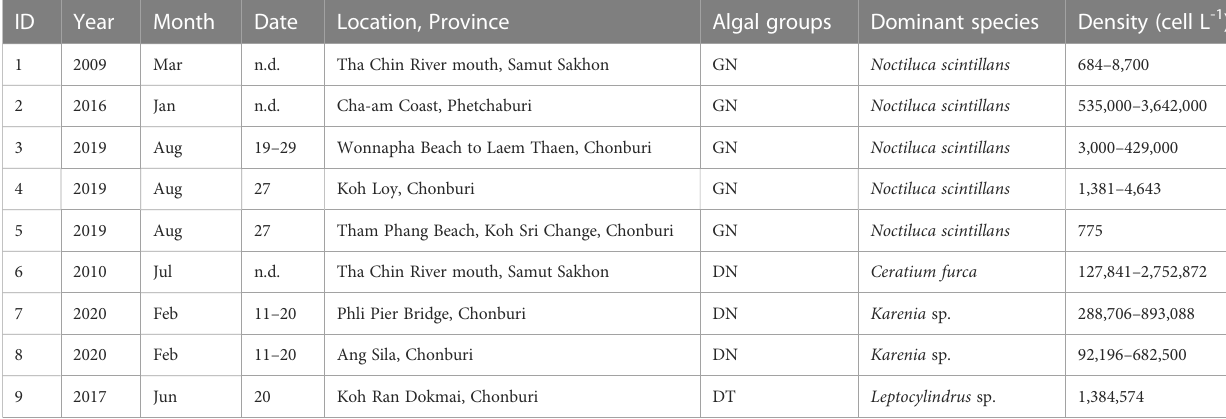
spectra were relatively low in the violet to blue (400 – 490 nm; <0.00034 sr -1 ) and red (min. between 664 and 668 nm;<0.00064 sr -1 ) wavelengths. These relatively low R rs characteristics have never been documented in the measured spectrum of green Noctiluca in the northern Arabian Sea (Dwivedi et al., 2015), although a peak in green (max. between 557 and 558 nm; 0.0008 – 0.0051 sr -1 ) wavelengths corresponded to the noticeable green color of the bloom. Furthermore, extraordinarily high R rs (>0.01 sr -1 ) was observed in the red to near-infrared (NIR) wavelengths (~706 to ~825 nm), with decreasing R rs in the visible wavelengths. Noctiluca blooms exhibited much lower chl-a concentrations (Figure 3B) than SGN blooms. The high NIR observed in the SGN spectra disappeared in these blooms (Figure 3H) and remained as only a small peak in the red-to-NIR wavelengths associated with the chlorophyll fl uorescence peak. The signature of increasing re fl ectance from blue to green wavelengths for the green Noctiluca bloom spectrum reported in the Arabian Sea (Dwivedi et al., 2015) was also observed in the R rs spectra of these groups, but was considerably lower in the blue wavelength and higher in the peak of the green wavelength (max. between 554 and 564 nm; 0.0028 to 0.0063 sr -1 ). Group 4. Dino fl agellate Ceratium furca blooms (DN>60%) had high chl-a (Figure 3C) and discolored the seawater to red (Figure 2C). Green R rs values decreased rapidly from long to short wavelengths and were lower than those of the GN>80% and GN>40% blooms. This characteristic may be related to the enhanced absorption of peridinin, a marker pigment of dino fl agellates (Clementson and Wojtasiewicz, 2019). R rs spectra showed two peaks in yellow (max. between 574 and 577 nm; 0.004 to 0.0053 sr -1 ) and red-to-NIR (max. between 696 and 701 nm; 0.0025 to 0.0058 sr -1 ) wavelengths. These two peaks arose during intense blooms, particularly the red-to-NIR peak. Group 5. Diatom blooms (DT>80%) were observed in medium chl-a (Figure 3D), which had the lowest chl-a among all blooms. The R rs spectra peaked in the yellow band (max. between 568 and 572 nm; 0.0045 – 0.0068 sr -1 ), similar to dino fl agellate blooms; however, violet to green values were higher in diatom blooms. The higher re fl ectance in green wavelengths compared to